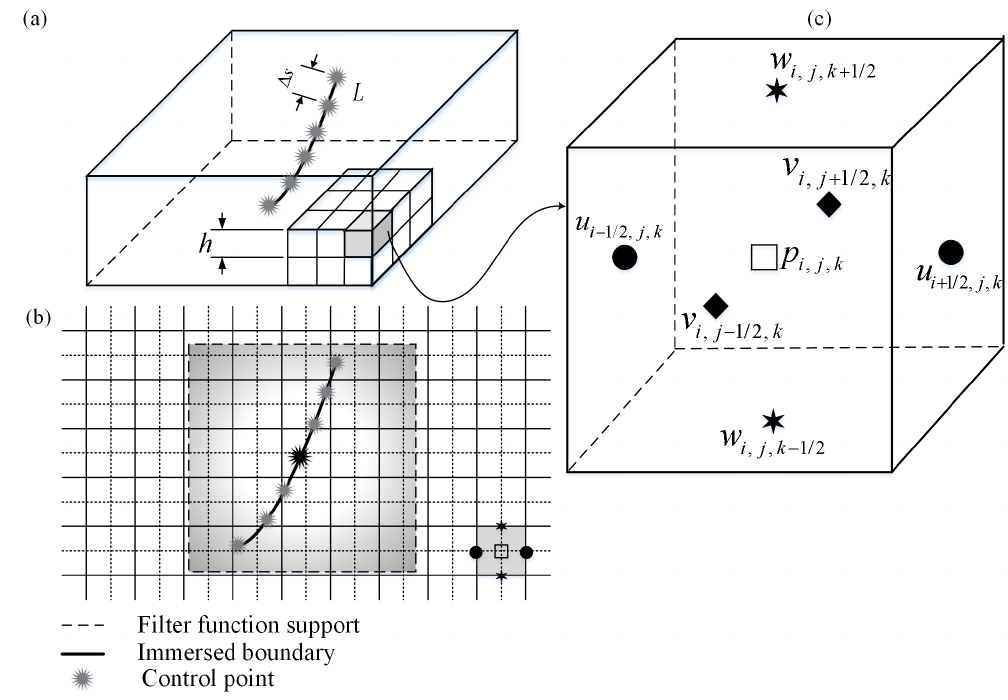
Figure 2. ( a ) Flow domain with an immersed boundary (IB). ∆ S is the spacing between the control points, and h = ∆ x = ∆ y = ∆ z is the grid spacing. ( b ) Interpolation strategy of the immersed boundary method. ( c ) The MAC mesh cell. The velocity components u , v , and w are defined at the cell faces, while the pressure p is introduced at the cubic cell